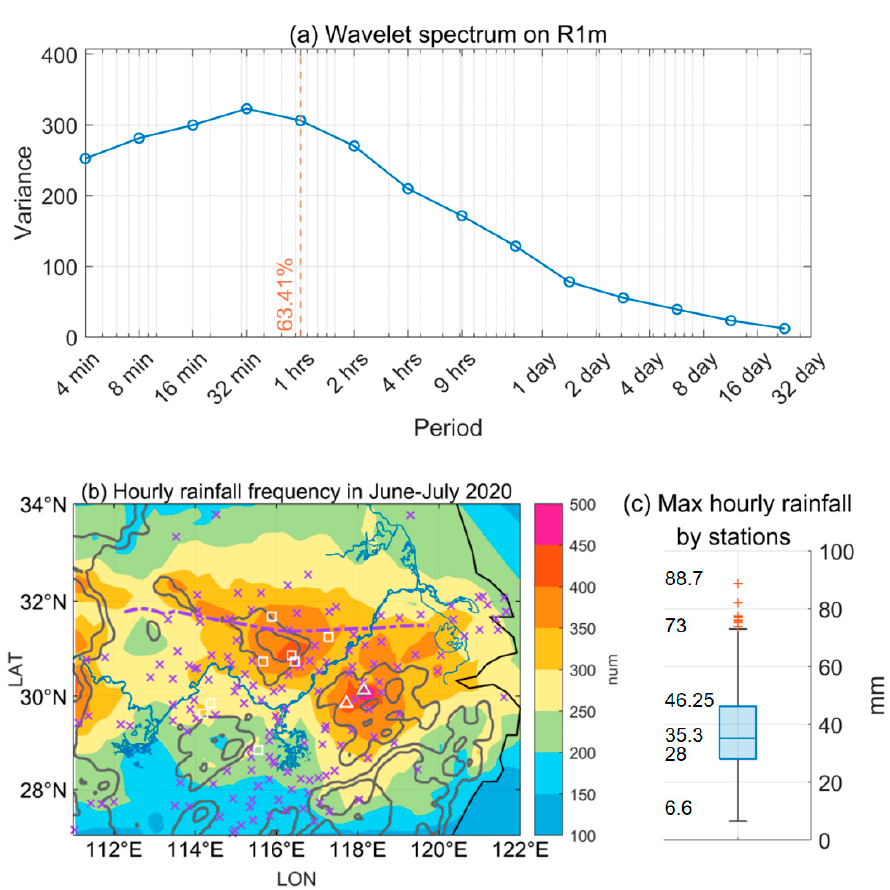
Figure 3. ( a ) Wavelet spectrum using the DWT method on 1 min Meiyu rainfalls in June–July 2020, standardized by the number of Meiyu days. The accumulated contribution from wavelet variance in the sub-hourly and hourly periods (2 min to 1 h) is 63.41% as labeled by the red line. The X -axis represents the range of time scales from minutes to 32 days. The Y -axis is the wavelet variance at each time scale. ( b ) This is similar to Figure 1, but for the hourly rainfall frequency (shading; unit: num) during the months of June and July 2020. National rain gauges observed heavy hourly rainfalls ( ≥ 15 mm h − 1 ) in the frequency of the top two in 26 counts, more than 20 counts, and 10–20 counts in June–July 2020, which are labeled by white triangles, white squares, and purple crosses, respectively. ( c ) The box and whisker plot of the maximum hourly rainfall recorded by each of the 480 rain gauges’ stations over the YHRB in June–July 2020. The blue box’s upper and lower boundaries show the 25th and 75th interquartile range. The horizontal line in the box indicates the median value. The upper and lower black lines are the maximum and minimum outliers, which are calculated by q 1 + 1.5 × ( q 3 − q 1 ) and q 3 − 1.5 × ( q 3 − q 1 ) , respectively, where q 1 and q 3 are the 25th and 75th quantile. The values greater than the maximum outliers are labeled by a red